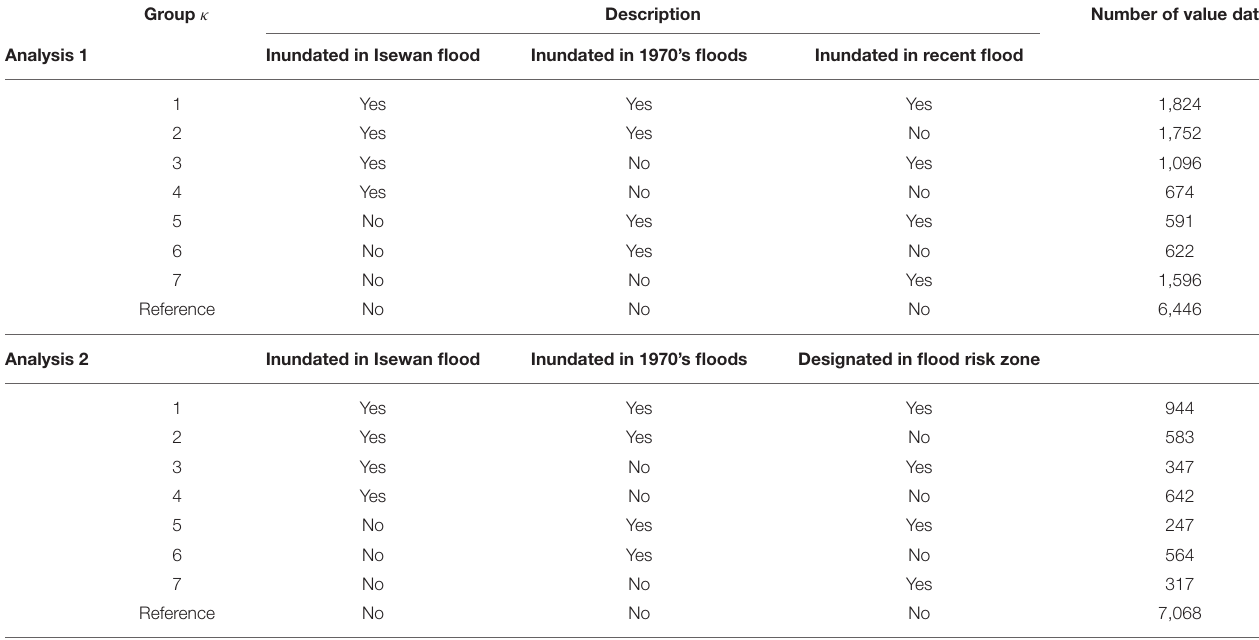
TABLE 2 | Settings of treatment and reference